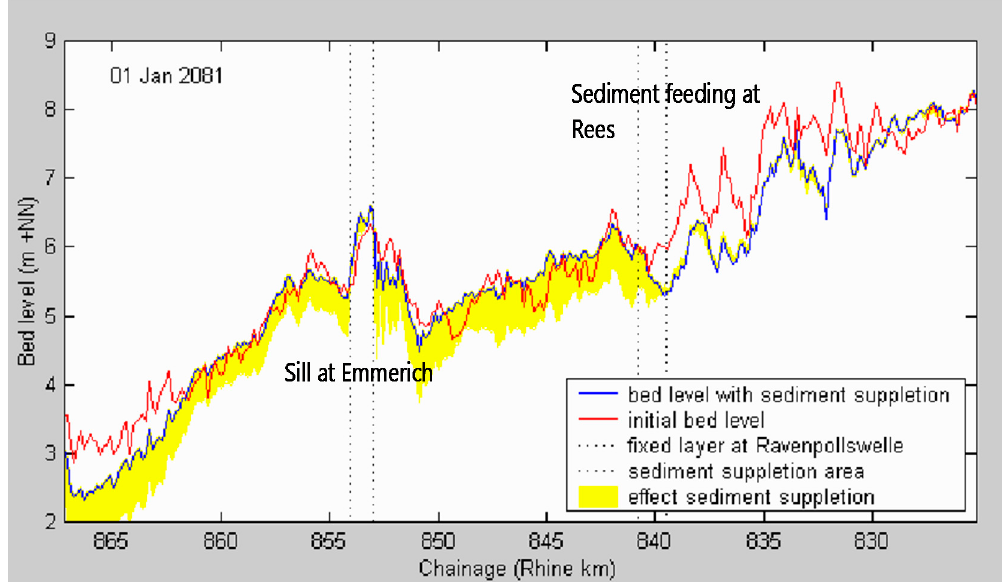
Figure 25. Bed degradation in 80 years and the effect of sediment supply in Rees (copyright [25]). Table 4. Forecast of bed-level changes in Bovenrijn and Waal branches (copyright